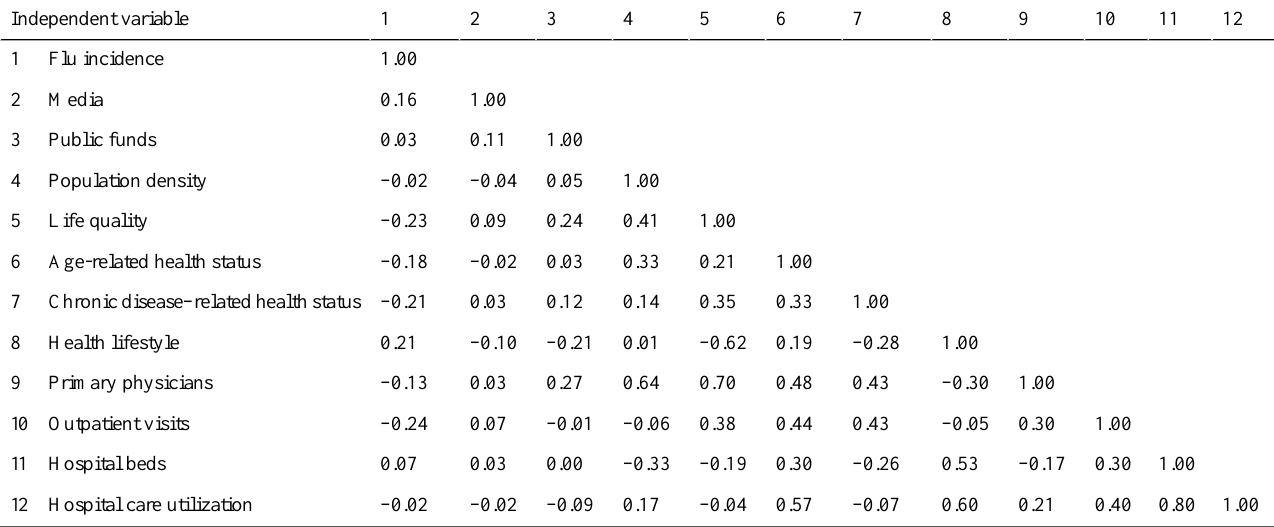
Table 5. Correlation matrix of independent